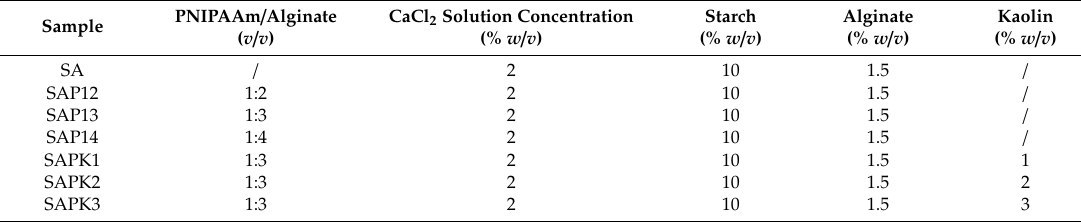
Table 1. Formulation parameters for the synthesis of hydrogel beads.